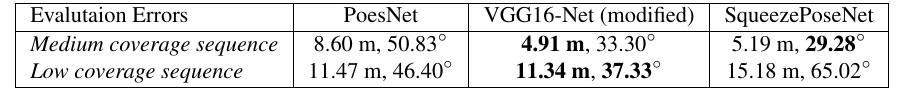
Table 1: Position and rotation errors on the medium respectively the high coverage sequence . Bold text marks best result on a sequence.